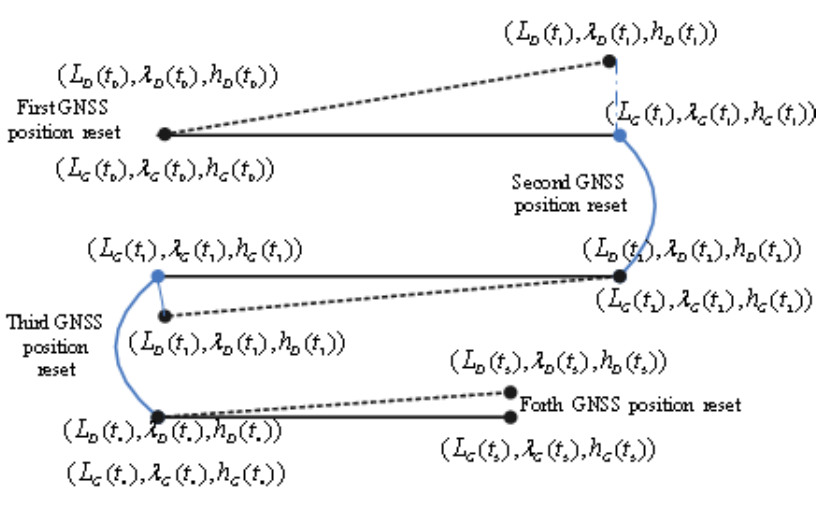
Figure 2. An iterative implementation